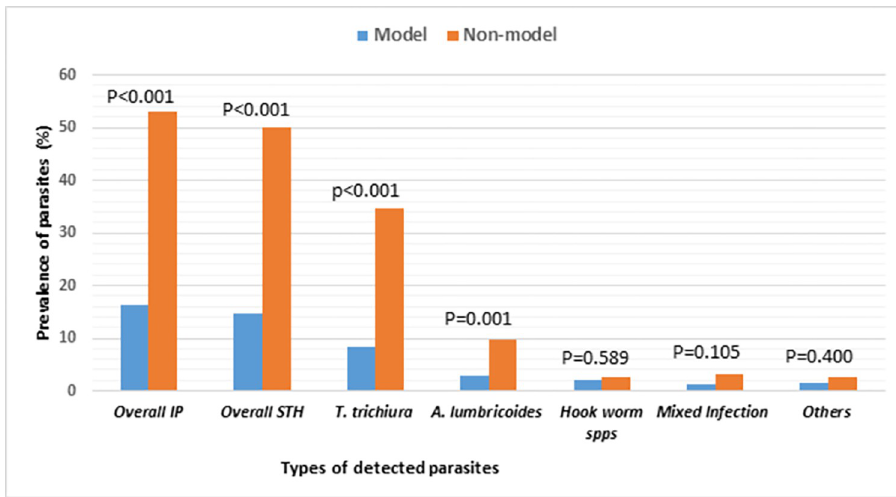
Fig 2. Prevalence of STHs and mixed parasitic infections among individual participants of model and non-model HHs, Seka Chekorsa woreda, Southwest Ethiopia. Key: IP: Intestinal parasites, others: ( E . vermicularis , E . histolytica / dispar , and Taenia species), mixed infection: Multiple infections of STHs parasites or with any of other types of parasites.